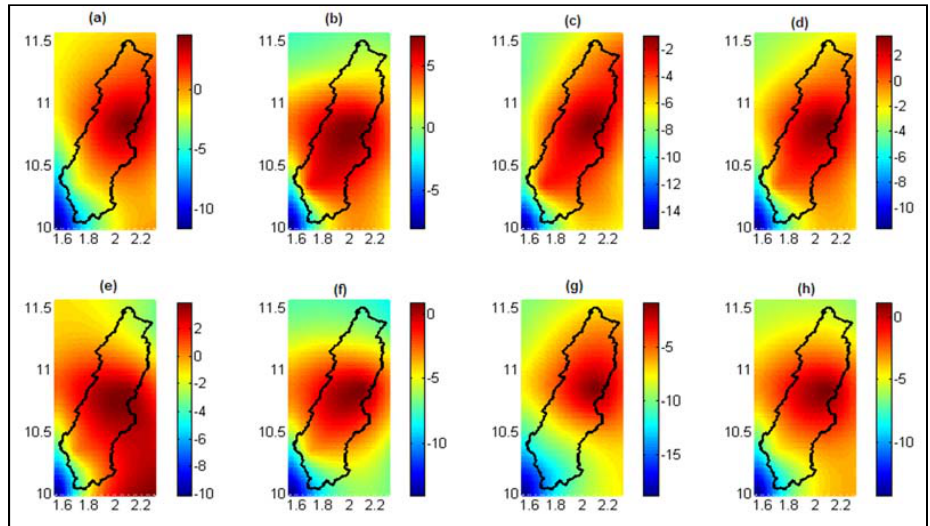
Figure 8 . Changes in the length of the rainy season (%) compared to the reference period: a : RCP4.5 ‐